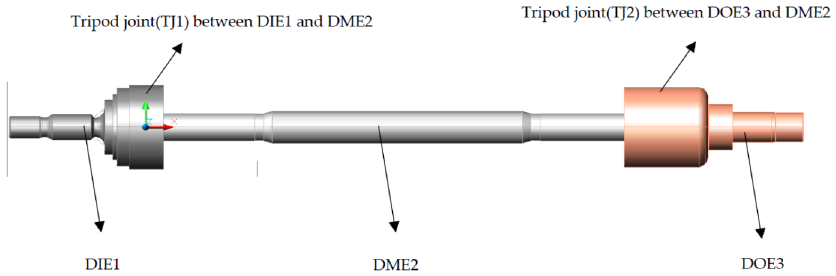
Figure 3. The driveline transmission of a DTID.